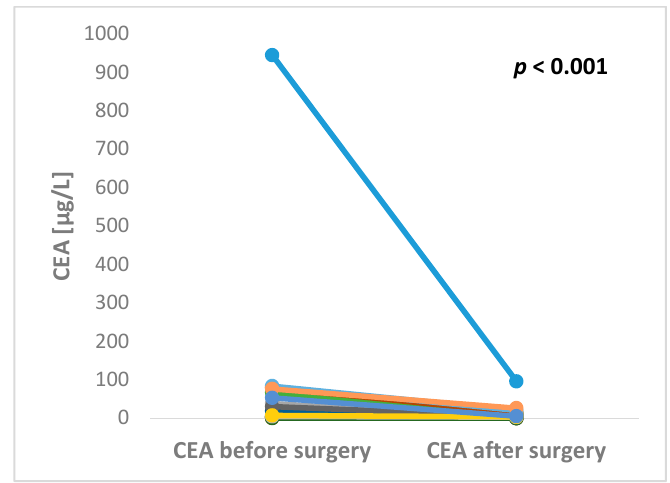
Figure 2. Significant changes in CEA levels between pre- and post-operative blood samples in patients undergoing surgery for colorectal cancer liver metastases ( p < 0.001).